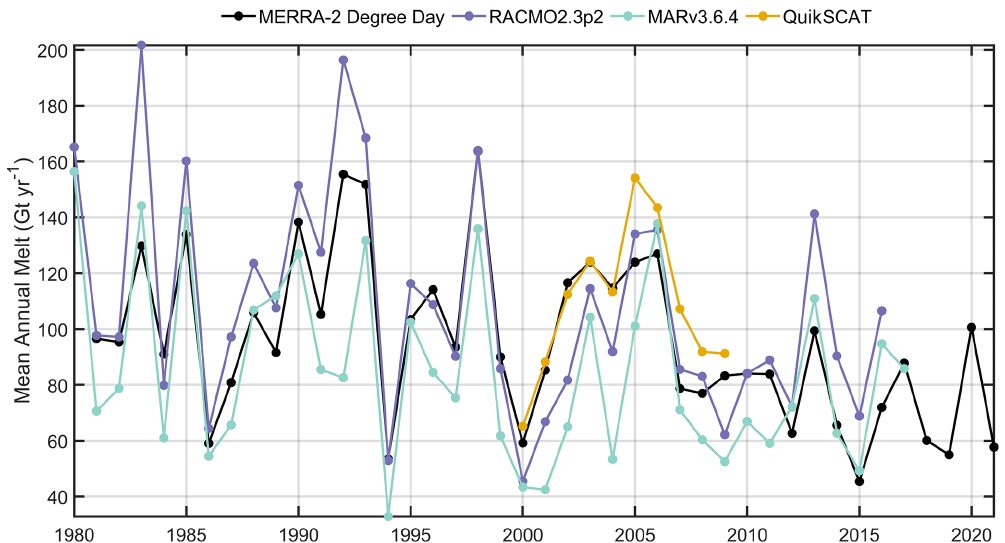
Figure 25. Comparison of annual melt from the MERRA-2 degree-day model (Sect. 2.2.1) and Trusel et al. (2013) QuikSCAT-derived surface meltwater fluxes used to calibrate the degree-day model, as well as two regional climate models, RACMO2.3p2 (Van Wessem et al., 2018) and MARv3.6.4 (Agosta et al.,